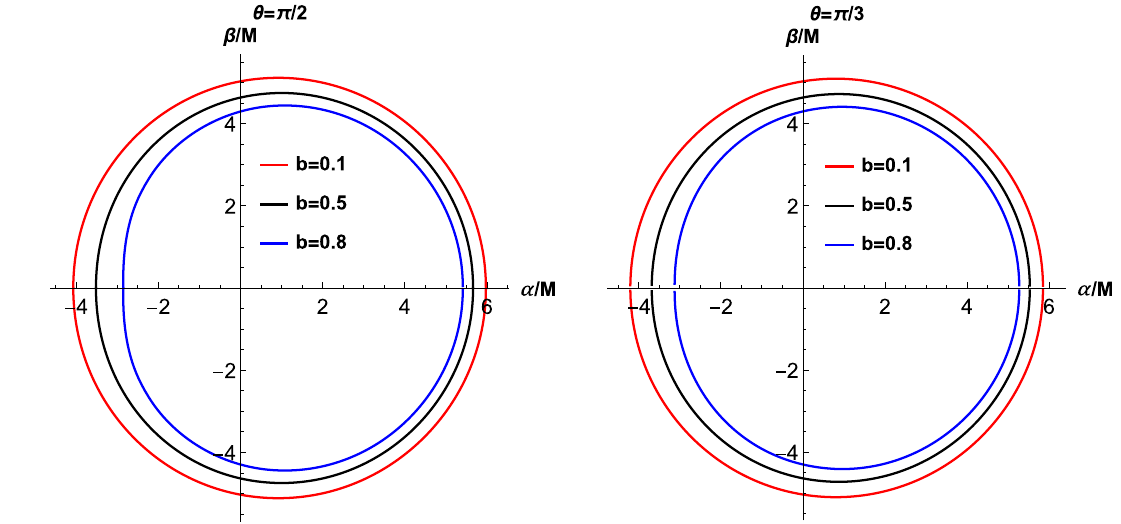
Fig. 3 The figure of the shadows for different values of b when θ = π